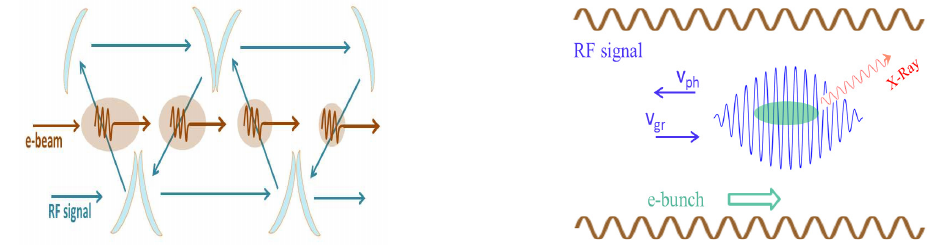
Figure 16. Mirror model of the intra-guide RFU propagation ( left ) and helical ripple waveguide and flying RFU pulse ( right ).